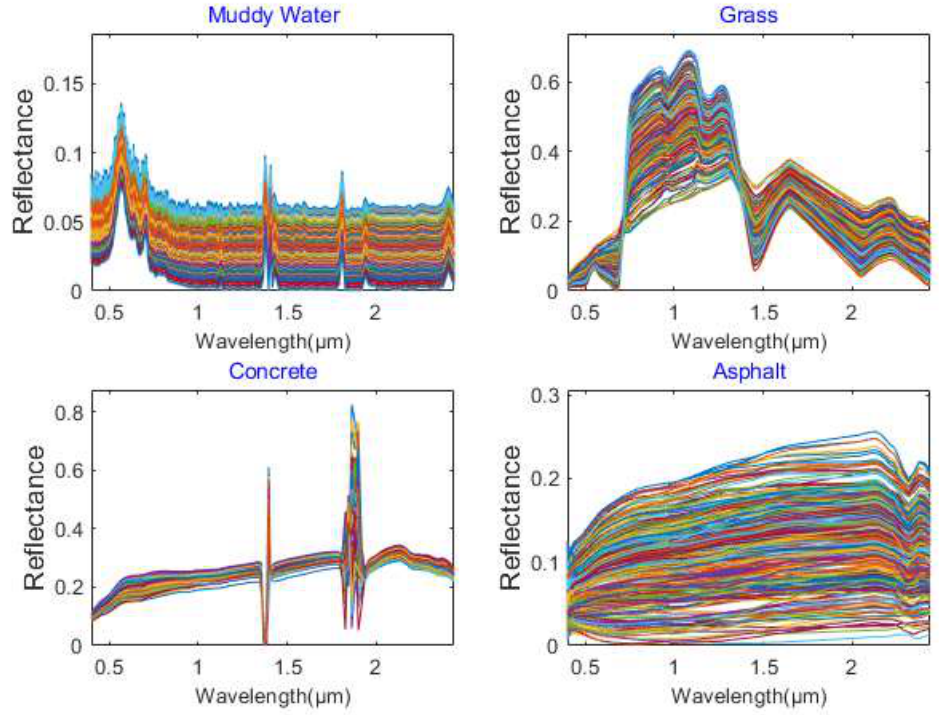
Figure 4. The spectral profile of the four materials in the DIRSIG spectral